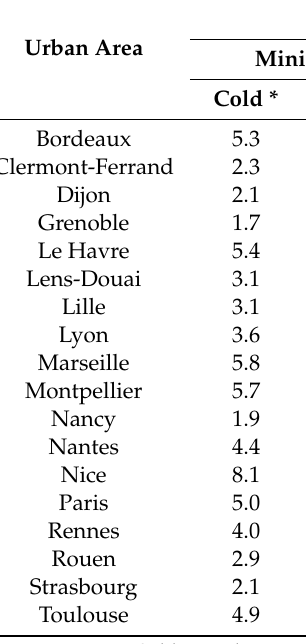
Table 3. Temperatures in 18 French areas: 2010–2014. Average Temperatures ( ◦ C) by Period Urban Area Minimum Maximum Mean Cold * Warm ** Cold * Warm ** Cold * Warm ** Bordeaux